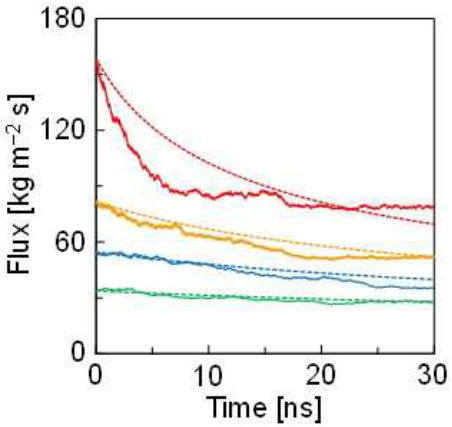
Figure 7. Changes in the flux during NEMD, where the ε of S Ar solute is doubled. The green, blue, orange, and red lines represent 3.0, 4.5, 5.9, and 9.1 wt.% of solute concentrations, respectively. The solid lines are obtained by NEMD. The dotted lines are estimated from Equation (3) with the solute concentration